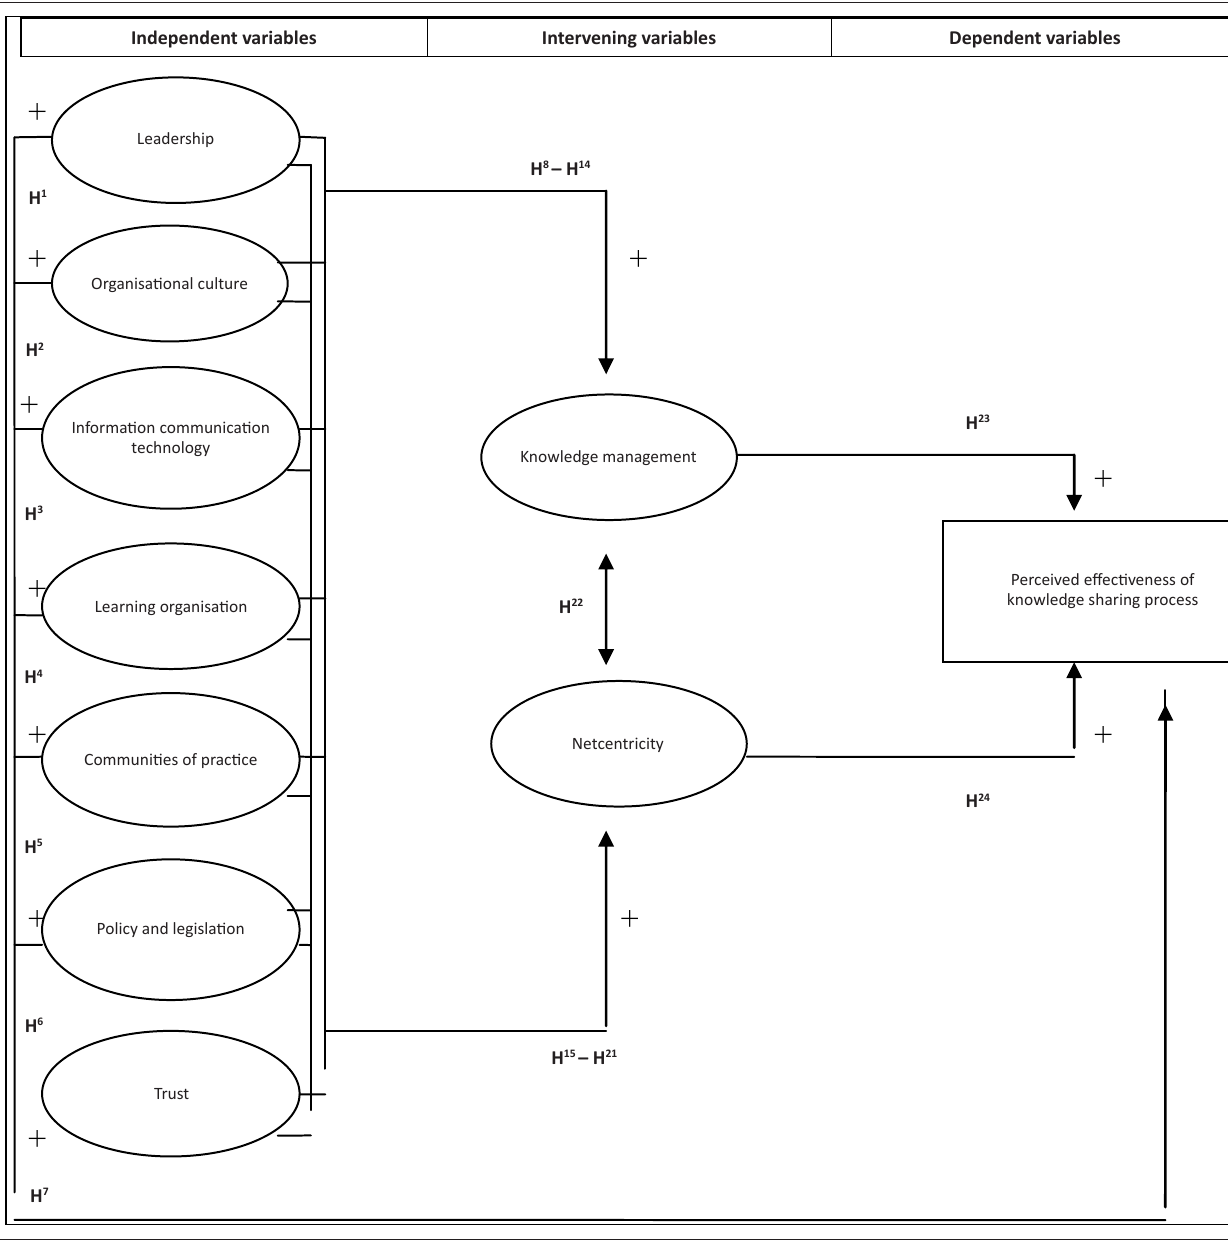
FIGURE 1: Theoretical model of perceived effectiveness on knowledge sharing.